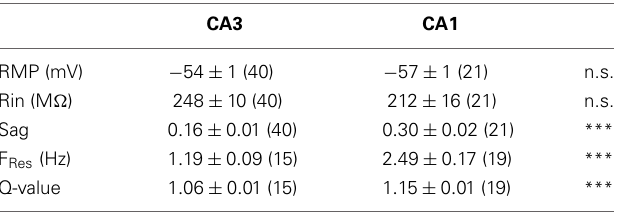
Table 3 | Passive membrane properties and resonance properties of CA3 and CA1 pyramidal